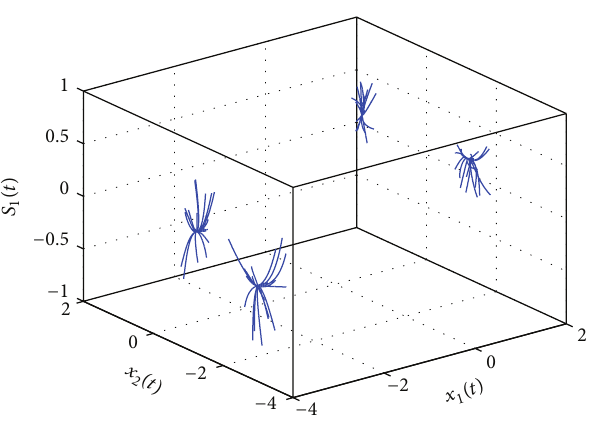
Figure 5: Phase plot of state variable (𝑥 1 , 𝑥 2 ,𝑆 1 ) 𝑇 in Example 1.